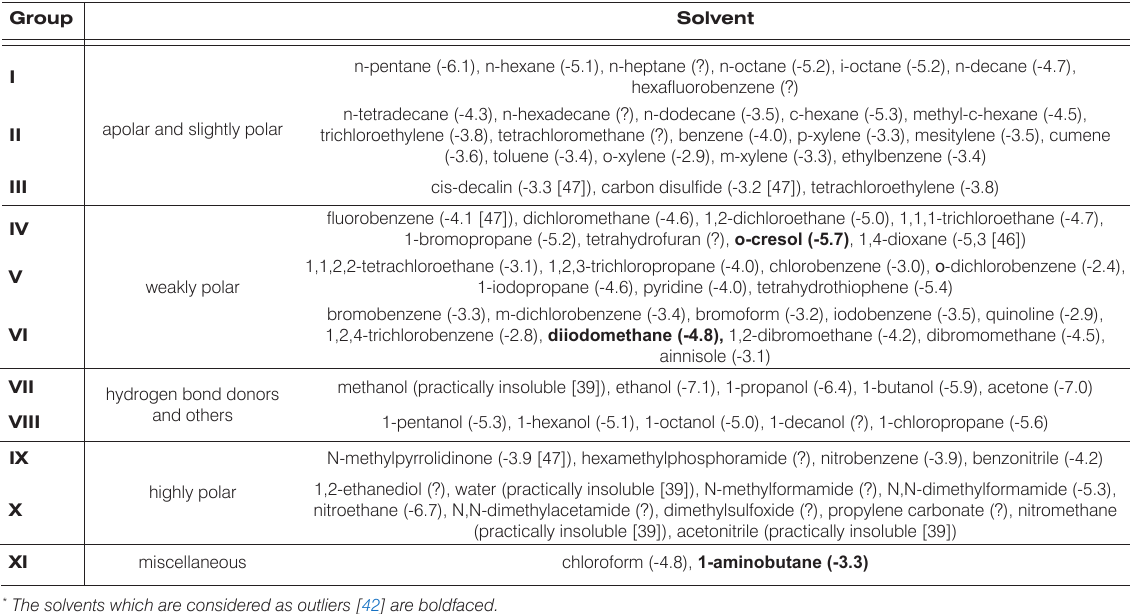
Table 7. The final classification of solvents. Values in the parenthesis are logarithms of C if the source of data is absent, the x values were taken from [ 42] * .